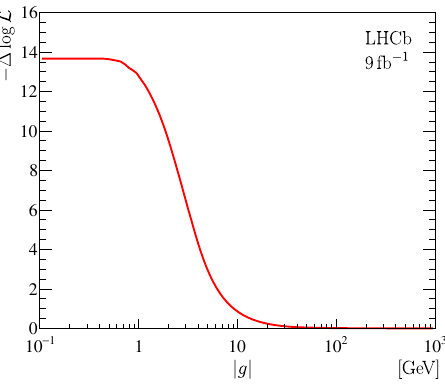
Fig. 1 Distribution of D 0 D 0 π + mass. Distribution of D 0 D 0 π + mass where the contribution of the non-D 0 background has been statistically subtracted. The result of the fi t described in the text is overlaid. Uncertainties on the data points are statistical only and represent one standard deviation, calculated as a sum in quadrature of the assigned weights from the background-subtraction procedure.